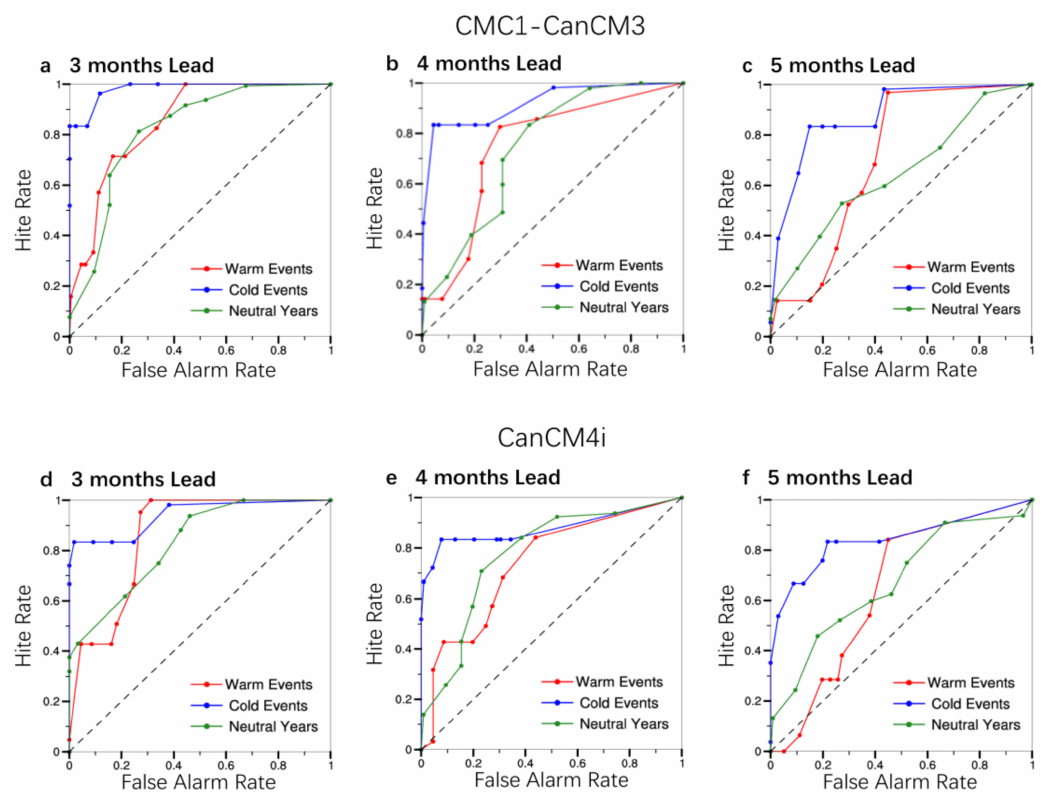
Figure 8. ROC curves of Atl3 index for a lead time of ( a , d ) three months, ( b , e ) four months and ( c , f ) five months from the model of ( a – c ) CMC1-CanCM3 and ( d – f ) CanCM4i. The Atlantic Niño (Atlantic Niña) events are denoted in red (blue) and the neutral conditions are in